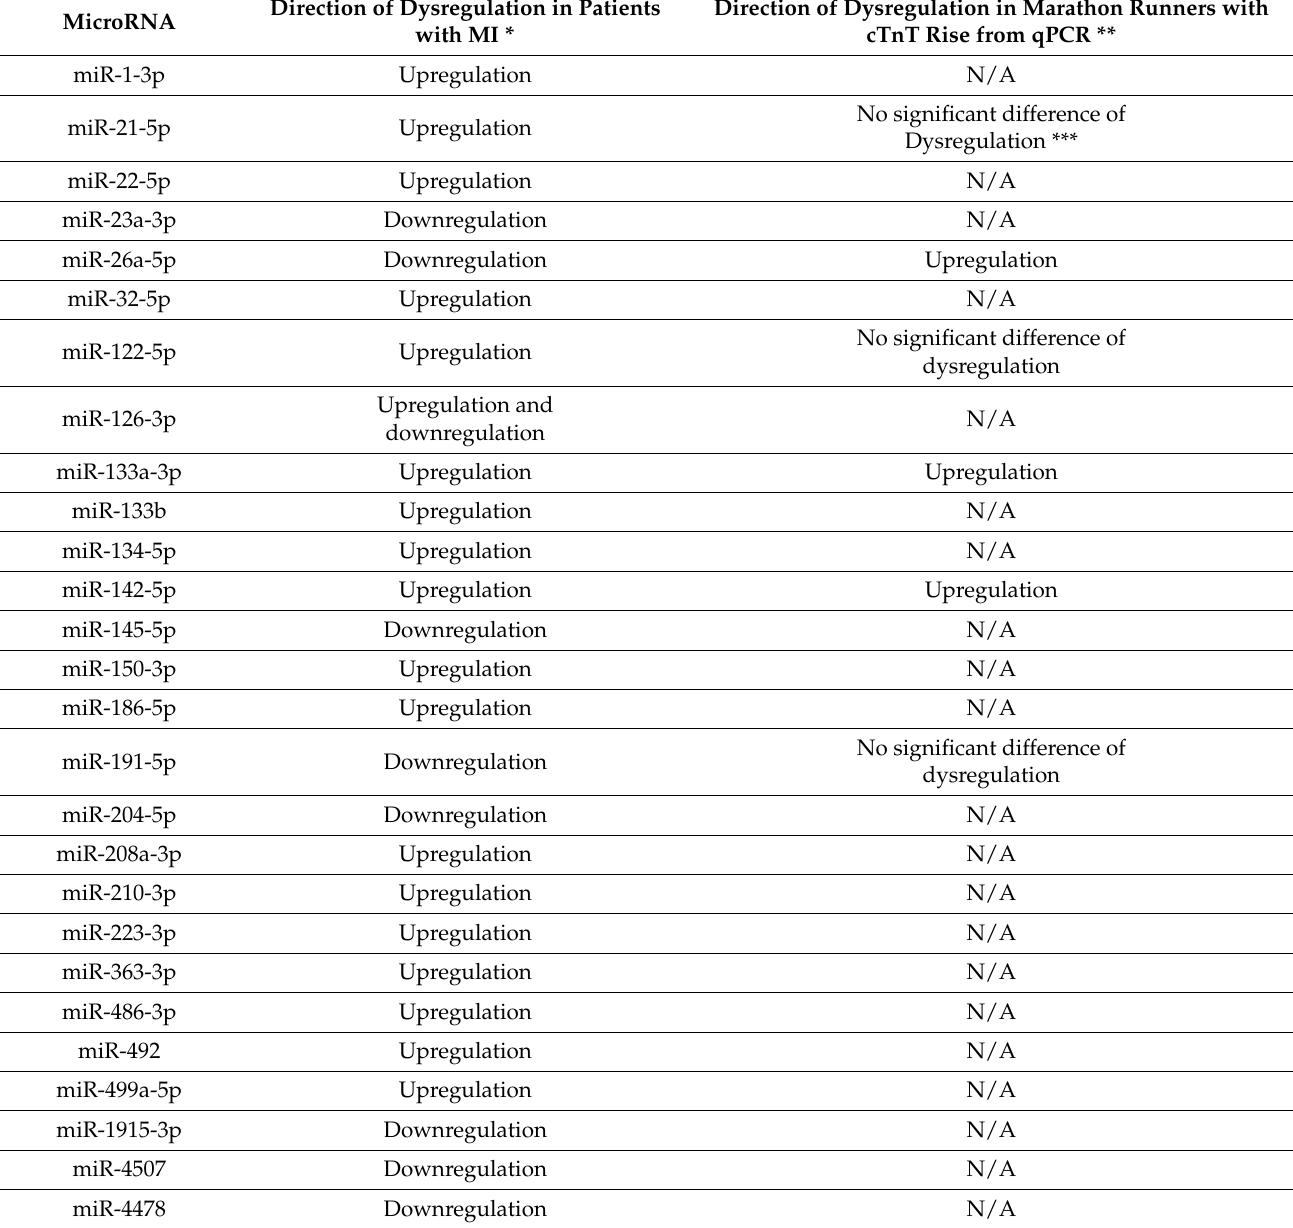
Table 5. Directions of microRNA dysregulation of patients with myocardial infarction and marathon